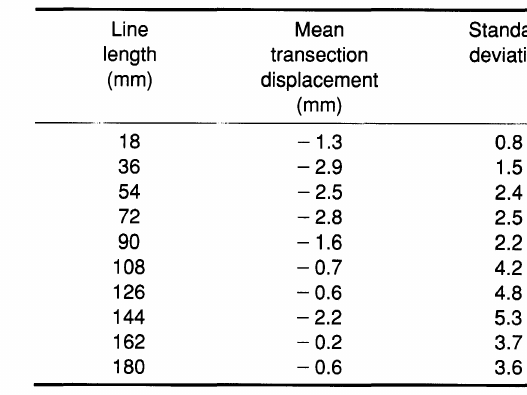
TABLE I. Accuracy of horizontal line bisection in patient